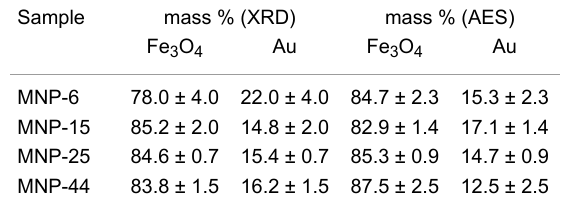
Table 2: Mass fraction of Fe 3 O 4 and Au in the samples, as deter- mined by XRD and AES analysis.